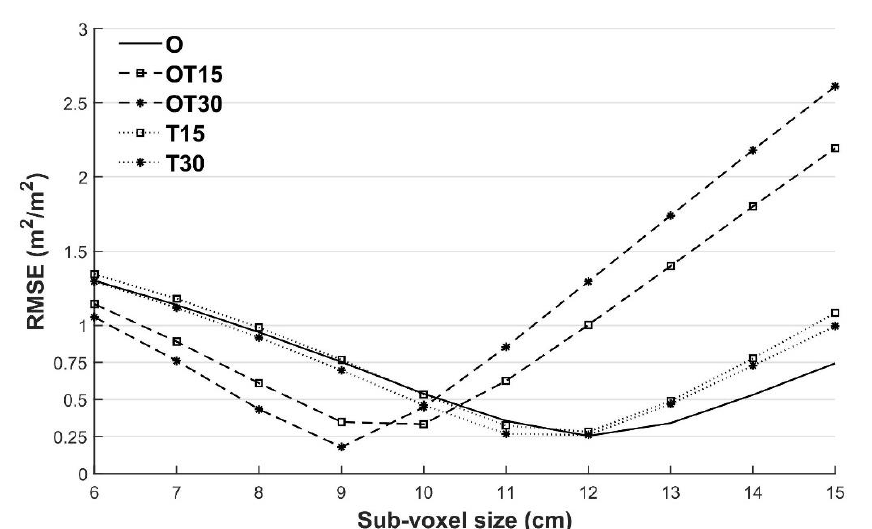
Figure 8. Root-mean-square error (RMSE) between the LAI derived from five schemes and effective leaf area index (LAIe) under different sub-voxel sizes.